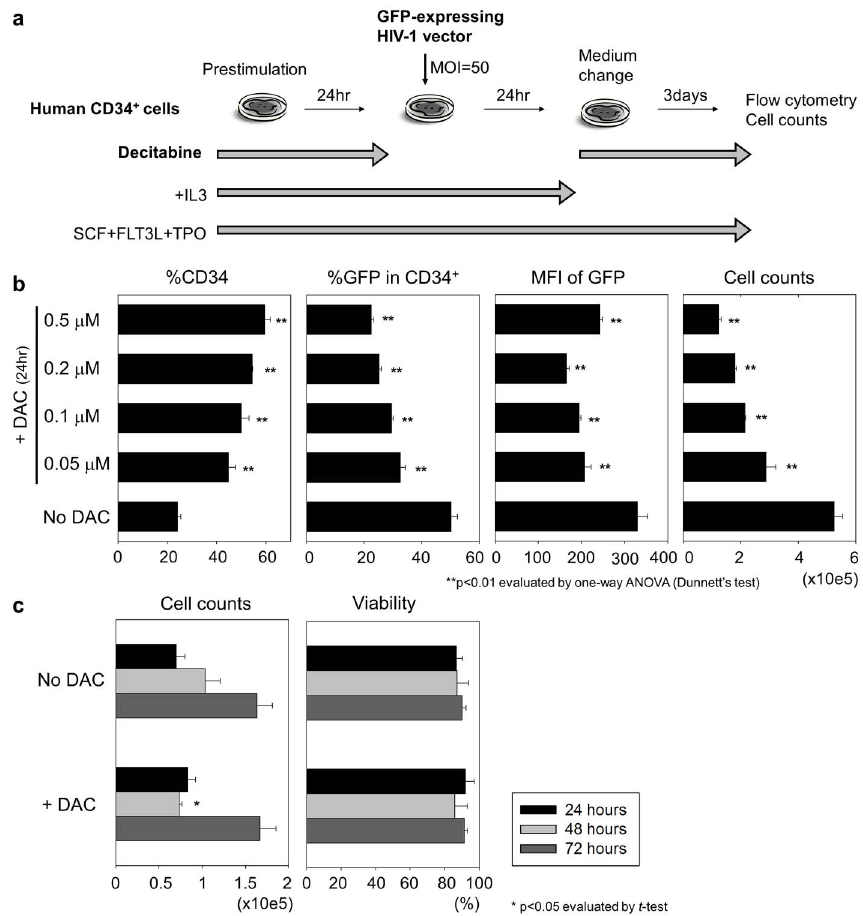
Figure 2. Decitabine increased CD34 expression and reduced cell proliferation in transduced human CD34 + cells. (a). To further investigate the decitabine effects on transduction efficiency for human CD34 + cells, we added increasing dose of decitabine (0.05, 0.1, 0.2, and 0.5 m M) into media during 24-hour prestimulation (SCF, FLT3L, TPO, and IL3). The GFP expression, CD34 expression, and cell counts were evaluated 4 days after transduction. (b). We observed dose-dependent effects of decitabine exposure, which resulted in higher %CD34, lower %GFP, and lower cell counts. (c). We evaluated cell counts and viability of human CD34 + cells at 24, 48, and 72 hours after decitabine exposure (0.5 m M) with cytokine stimulation (SCF, FLT3L, TPO, and IL3) without transduction. Decitabine exposure resulted in lower cell counts at 48 hours after exposure;